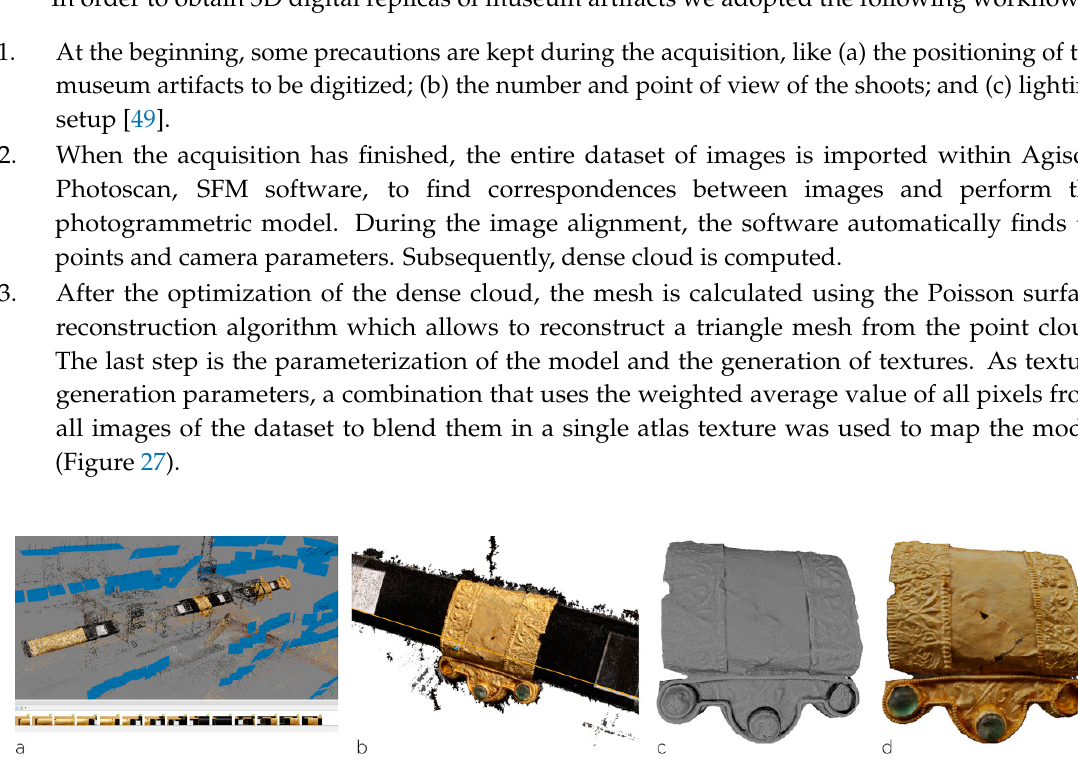
Figure 27. SFM workflow for the Kunàgota sword: ( a ) image matching and point cloud reconstruction; ( b ) dense point cloud filtering and cleaning; ( c ) result of mesh building with Poisson surface reconstruction algorithm; ( d ) result of texture building procedure; ( e ) virtual replica of the Kunàgota sword at the end of the workflow.